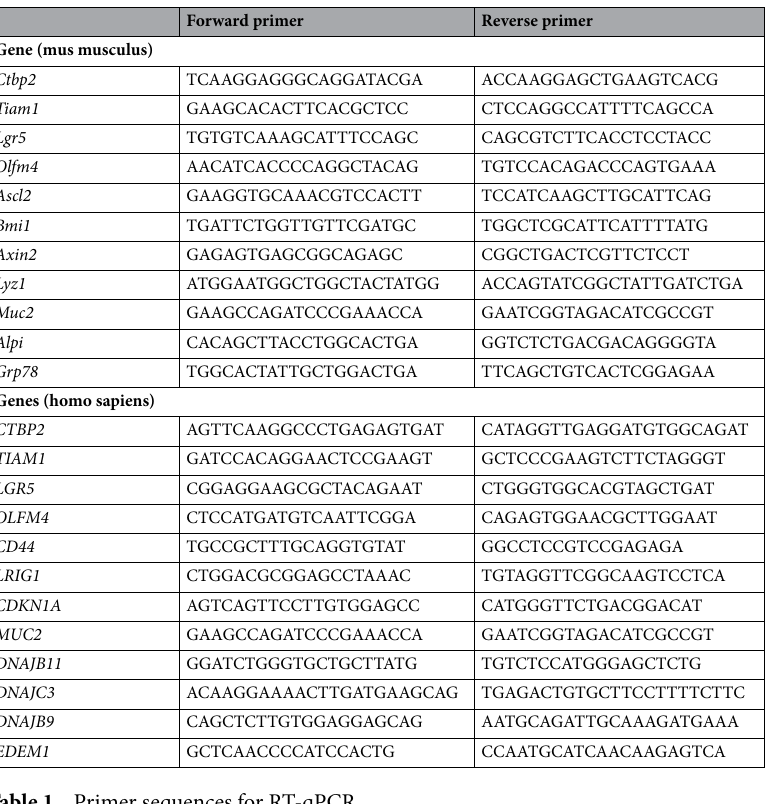
Table 1. Primer sequences for